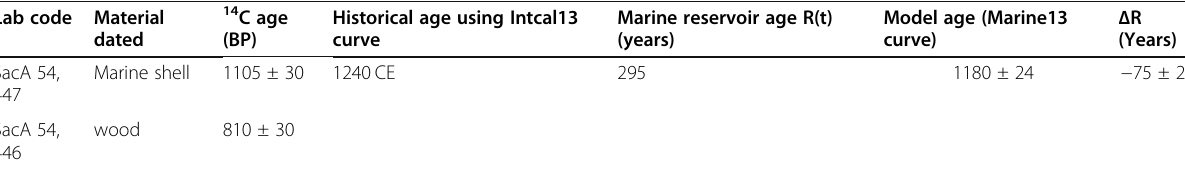
Table 1 Estimation of marine reservoir age R(t) and its regional deviation Δ R using 14C ages on wood and marine shell Lab code Material